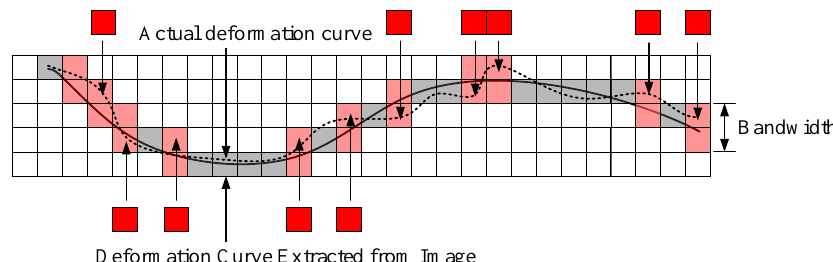
Figure 15. Di ff erence between pixel edge and actual Figure 15. Difference between pixel edge and actual edge.